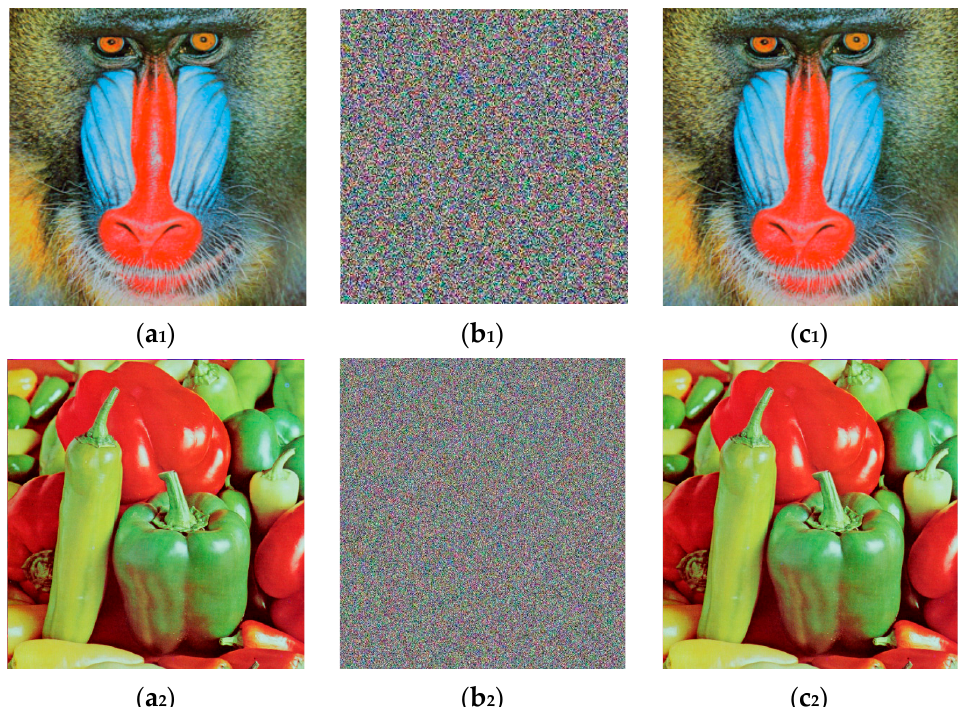
Figure 3. Some more standard RGB plain images along with their encrypted and decrypted versions; ( a ) Peppers (256 × 256 × 3); ( b ) encrypted peppers; ( c ) decrypted peppers; ( a 1 ) baboon (256 × 256 × 3); ( b 1 ) encrypted baboon; ( c 1 ) decrypted baboon; ( a 2 ) peppers (512 × 512 × 3); ( b 2 ) en- crypted peppers; ( c 2 ) decrypted